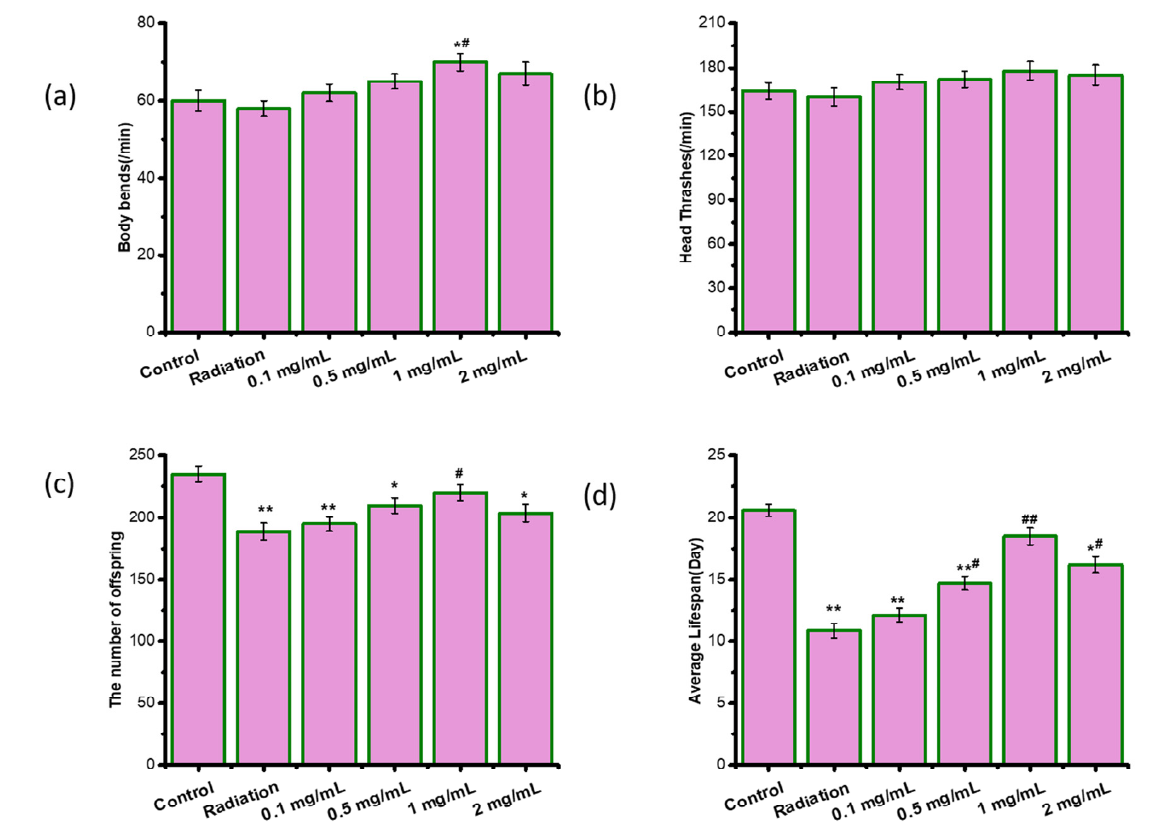
Figure 2. ASPS did not cause any toxic effects on radiation-damaged C. elegans . ( a ) The body bends. n = 20. ( b ) The head thrashes. n = 20. ( c ) The number of offspring. n = 20. ( d ) The average lifespan. n = 3. Significant difference from the control group was designated as * p < 0.05 and ** p < 0.01, and significant difference from the radiation group was designated as # p < 0.05 and ## p < 0.01, respec- tively.